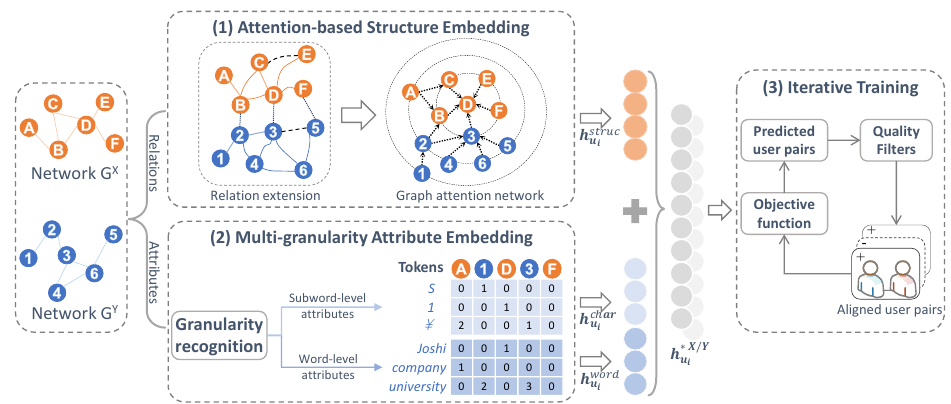
Figure 2. The overview of JARUA